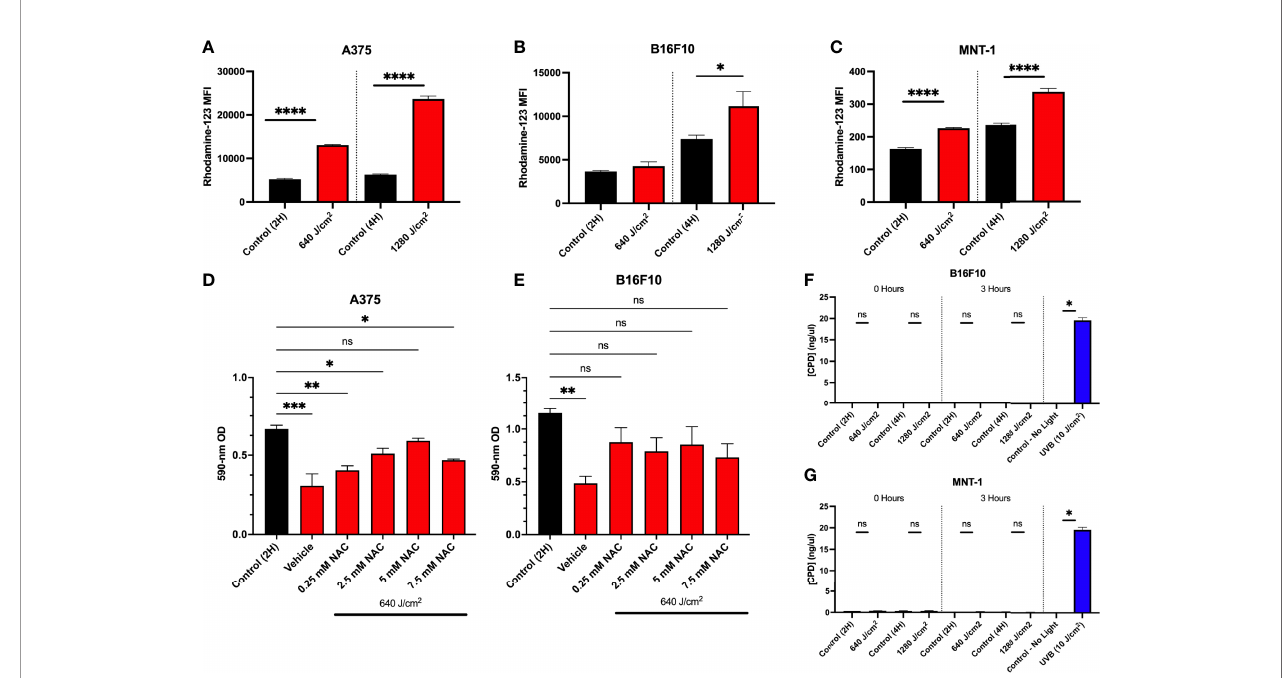
FIGURE 4 | Increases in ROS due to RL decrease cell proliferation. (A) A375 (n=3), (B) B16F10 (n=5), and (C) MNT-1 (n=4) cells were irradiated with 640 and 1280 J/cm 2 RL, and rhodamine-123 MFI was assessed at 0 hours post-treatment using fl ow cytometry. (D) A375 (n=4) and (E) B16F10 (n=5) cells were pretreated with 0.25 to 7.5 mM NAC and irradiated with 640 J/cm 2 RL. Cell count was assessed by measuring cell staining intensity with crystal violet 48 hours after irradiation. (G) B16F10 and (F) MNT-1 cells were irradiated with 640 to 1280 J/cm 2 RL or UVB (10 J/cm 2 ). DNA was collected at 0 and 3 hours post-irradiation and analyzed for CPDs using ELISA. RL and control MFI and CPD concentration for 640 and 1280 J/cm 2 RL was compared using a two-tailed T-test (p<0.05). ANOVA was used to compare RL and NAC treated groups to control. Cell count was assessed by measuring cell staining intensity with crystal violet 48 hours after NAC. Ordinary one- way ANOVA (p<0.05) compared NAC pretreatments and control. Dunnett ’ s post-hoc testing compared the mean of every RL group to control. 2H, 2 hour; 4H, 4 hour; UVB, ultraviolet B; NAC, n-acetylcysteine; OD, optical density. *denotes p<0.05, ** denotes p<0.01, *** denotes p<0.001, **** denotes p<0.0001, ns and denotes not signi fi